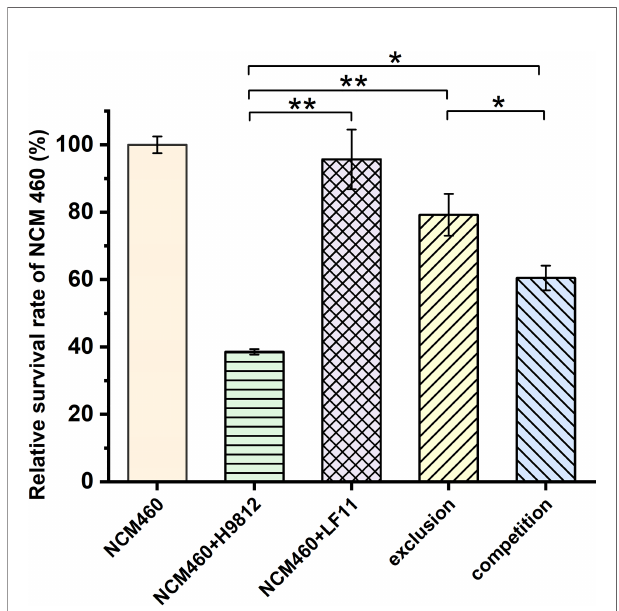
FIGURE 2 | The relative survivability of NCM460 cells with various treatments. The survival of the normal NCM460 cells is de fi ned as 100%. All data are given as means ± SD for n = 3. Statistical analysis is performed with Student ’ s t -test. * p < 0.05, ** p < 0.01.